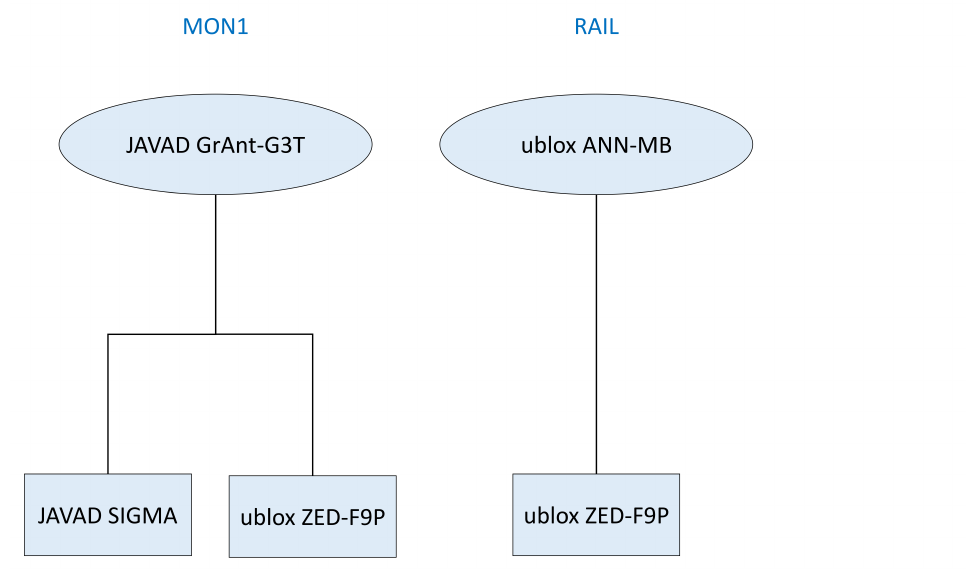
Figure 3. Session 1: receiver and antenna combinations for the experimental tests. For the dynamic tests with the seismic strong-motion signal, only the configuration of MON1 was